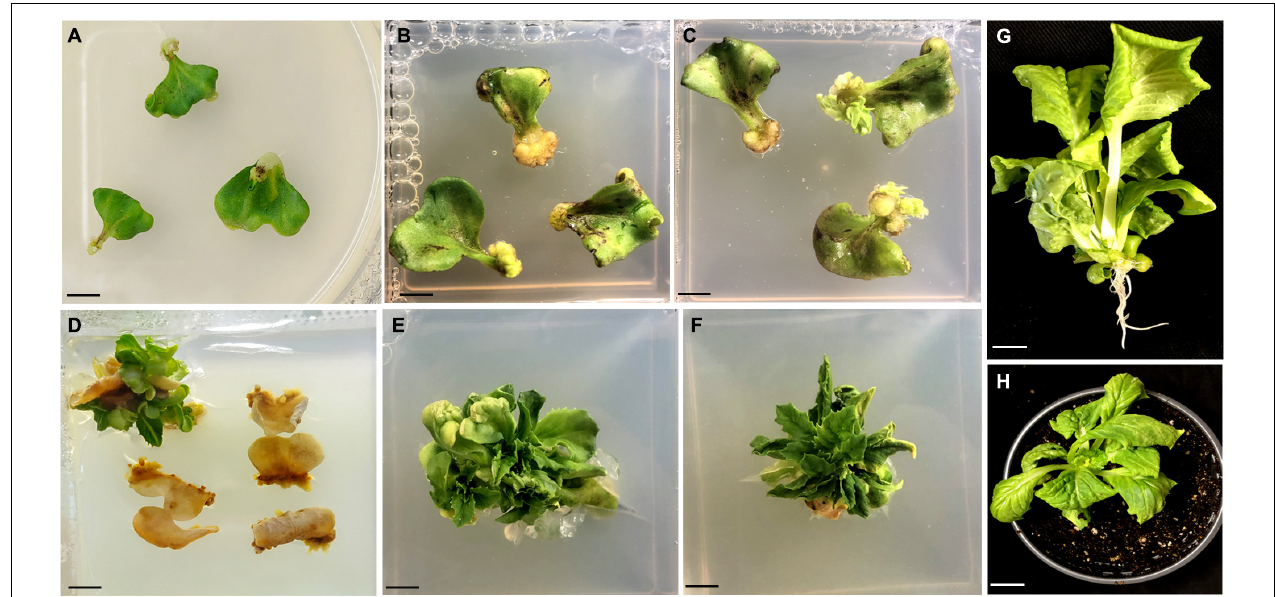
FIGURE 2 | Regeneration of plants from GV3101 + pCAMBIA1303 infected cotyledon explants of Chinese cabbage. (A) Co-cultivated explants after a week. (B) Bulging of petiole region of the explants after 2 weeks (C) Initiation of small shoots from petiole region of the explants after 4 weeks. (D) Proliferation of shoots from cotyledon explants after 8 weeks. (E,F) Production of well-grown shoots from cotyledon explants after 11 weeks. (G) A rooted plant. (H) A hardened plant. All the cultures showed in (A–F) were grown in MS hormonal medium containing 800 mg/L L-cysteine, 4 mg/L AgNO 3 , 500 mg/L timentin, 12 mg/L hygromycin. Scale bar represents 1 cm. TABLE 1 | Stable transformation efficiency of transgenic plants from cotyledon explants of B. rapa . Total no. of infected Total no. of shoots survived Total no. of Total no. of GUS Total no. of Southern Stable transformation cotyledon explants under third selection rooted shoots positive plants blot positive plants efficiency (%) 128 64.0b 38.0b 24.0b 18.0a 14.0a 128 72.0a 42.0a 26.0a 19.0a 14.8a 128 58.0c 34.0c 21.0c 17.0a